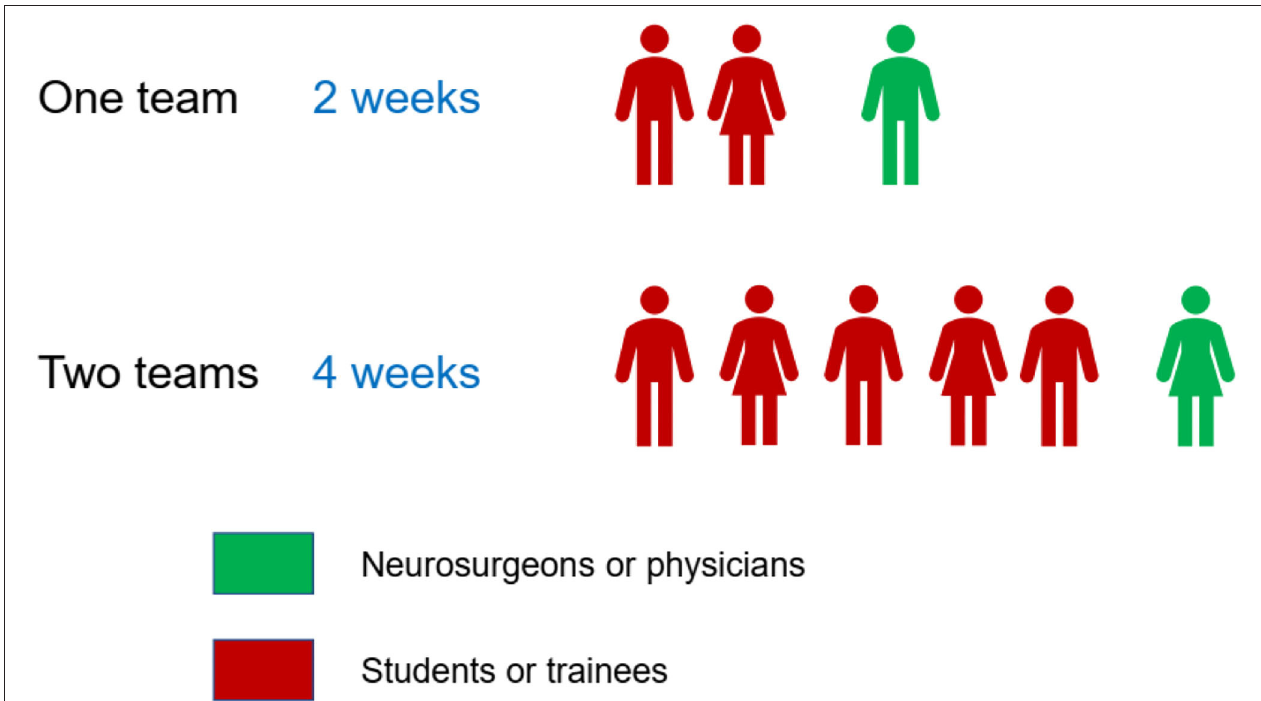
who provides care to TBI patients. Examples of some team Figure 1